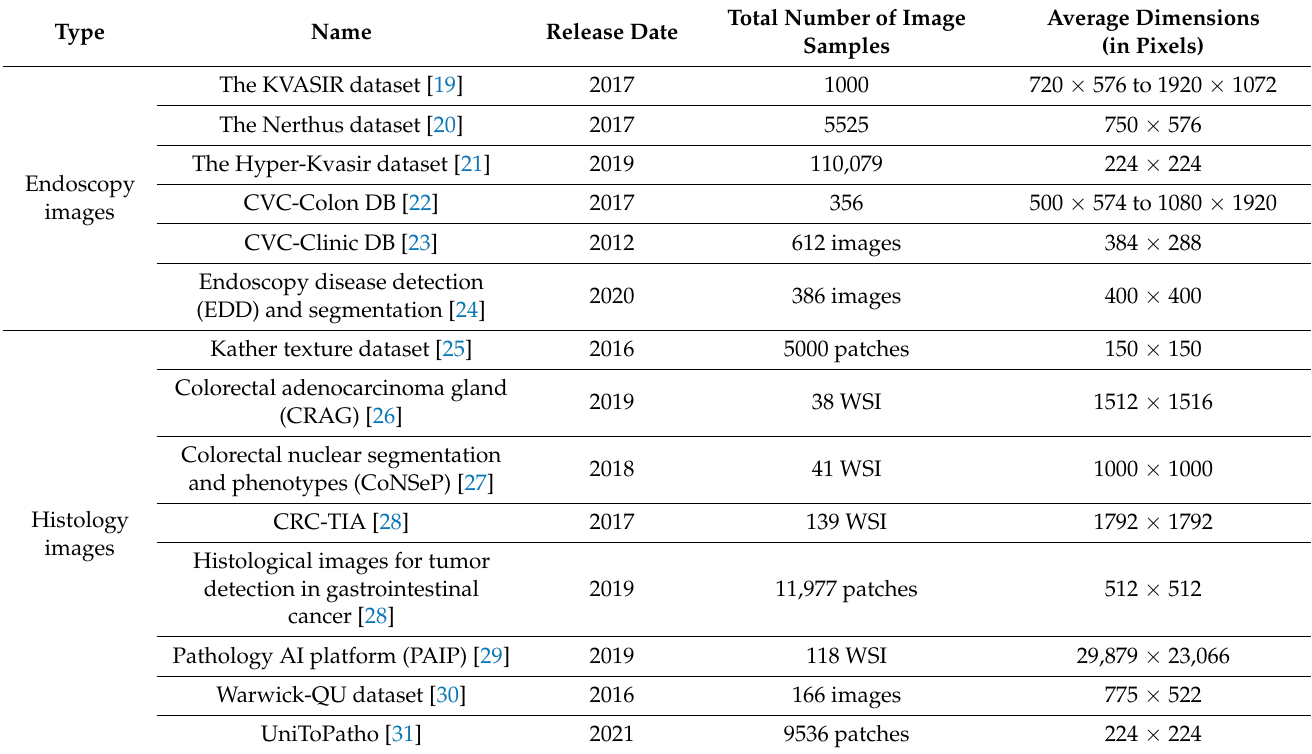
Table 2. Some of the publicly available CRC imaging